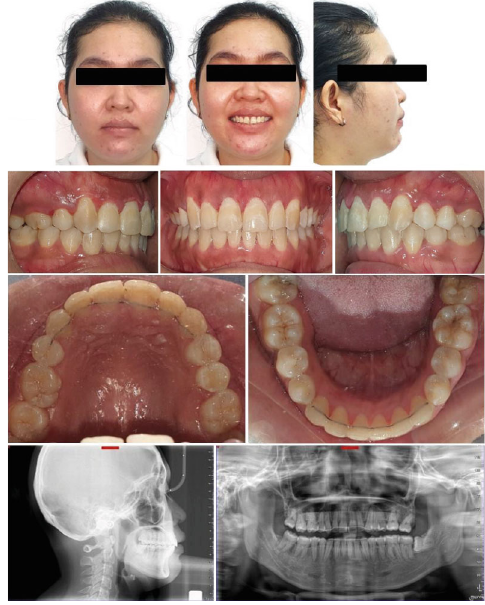
Figure 8: Posttreatment extraoral and intraoral pictures with radiographs after